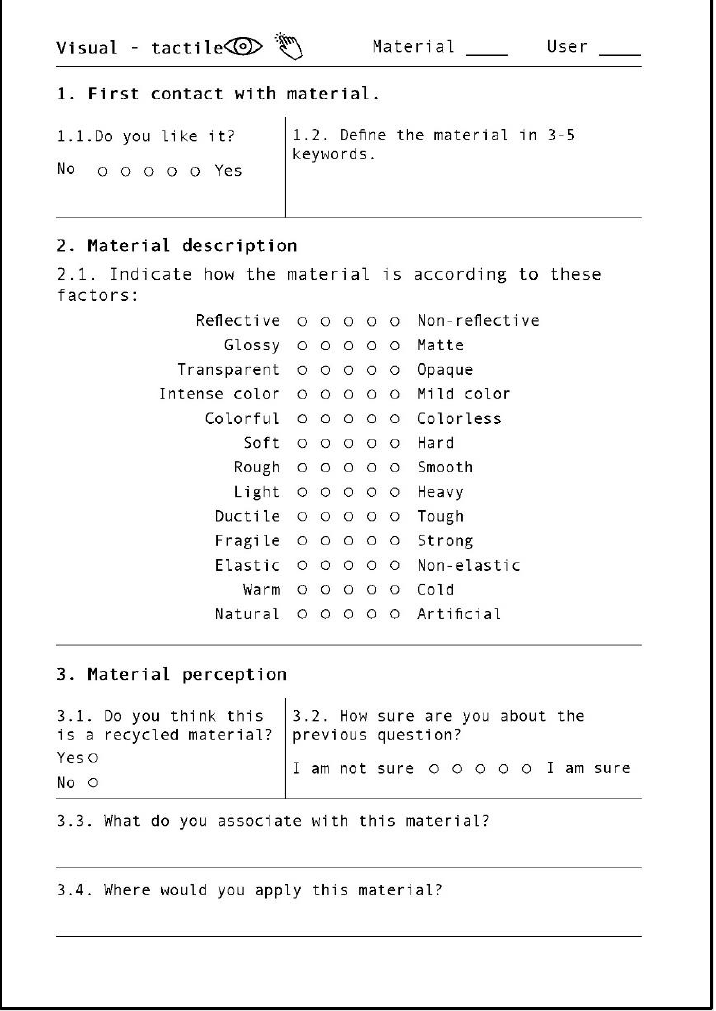
Figure 5. Sensory evaluation